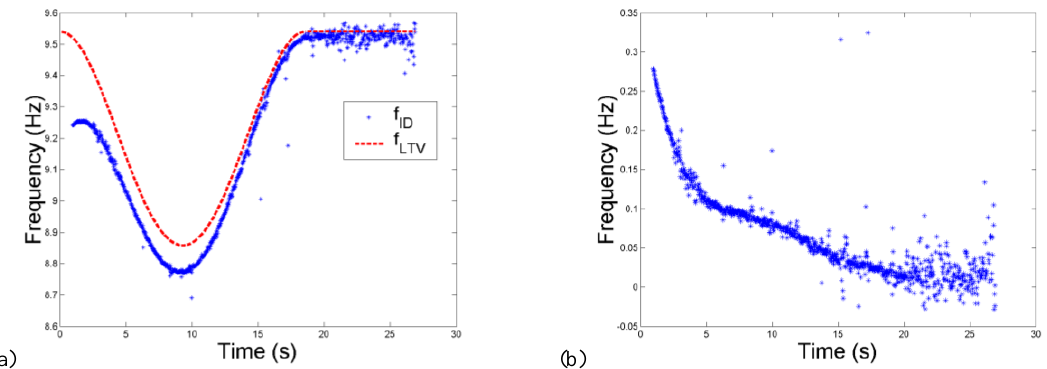
Fig. 3. First natural frequency extracted with the identification method compared with the theoretical natural frequency depending only on the moving mass (a) and difference between the two curves